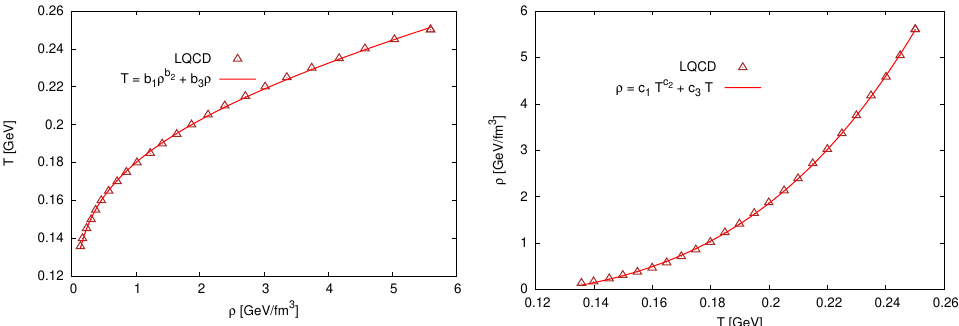
Figure 2. Left -hand panel depicts the temperature T in dependence on the energy density ρ . The right -hand panel shows the energy density ρ is shown in dependence on the temperature T . The sym- bols are lattice QCD calculations [22] and the solid curves represent to the proposed expressions, Equations (10) and (11),